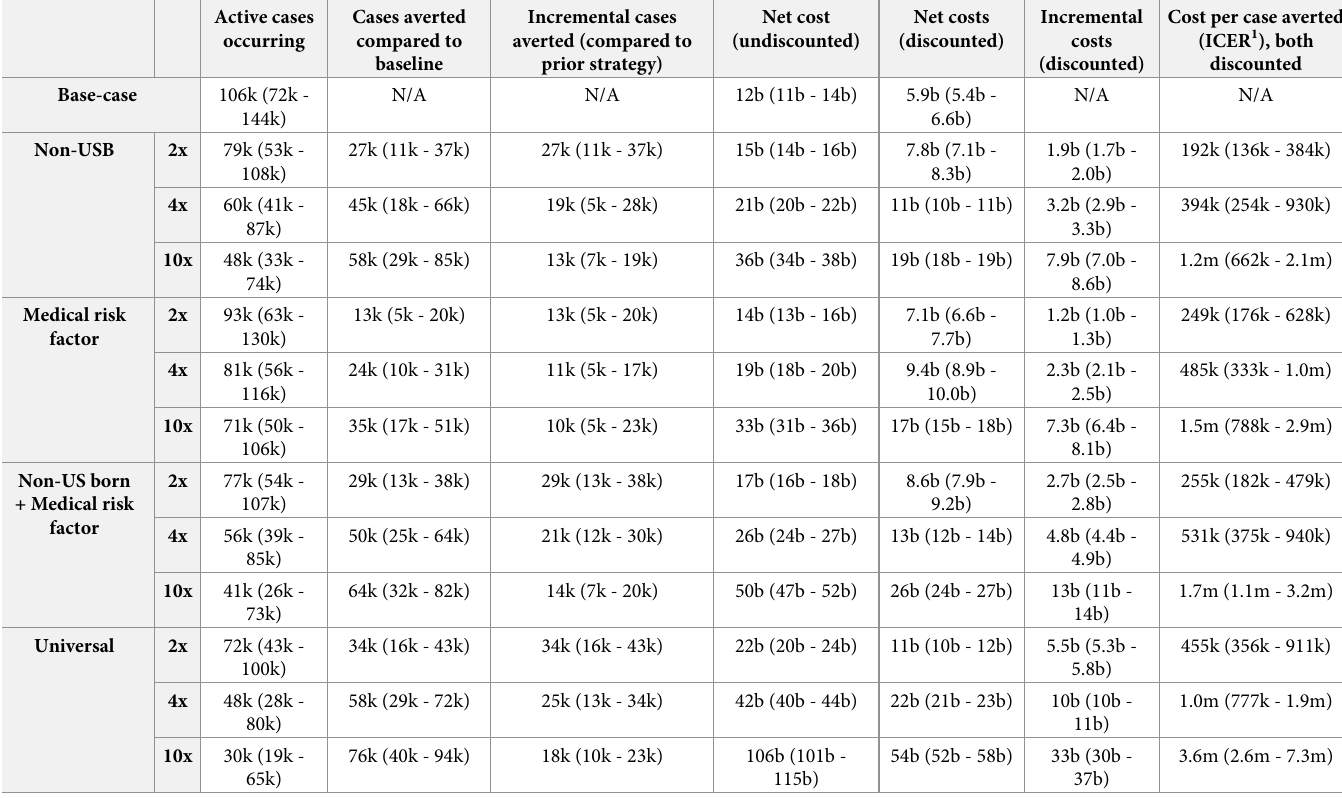
Table 2. Major results of TB targeted testing and treatment strategies by target population, 2017–2065, main analysis